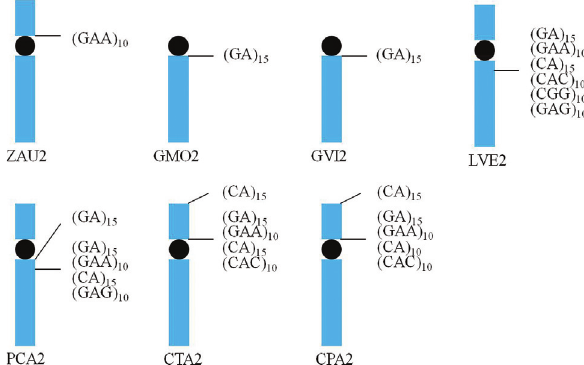
Figure 6 - Distribution and localization of microsatellite sequences in chromosome 2 of seven Columbidae species: ZAU ( Zenaida auriculata ), LVE ( Leptotila verreauxi ), PCA ( Patagioenas cayennensis ), GVI ( Geotrygon violacea ), GMO ( Geotrygon montana ), CTA ( Columbina talpacoti ) and CPA ( Columbina passerina ).